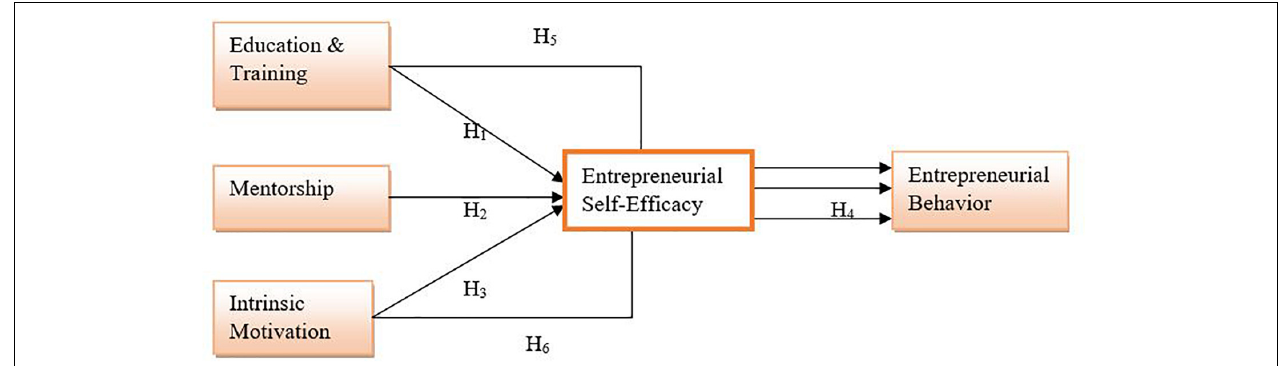
FIGURE 1 | Conceptual